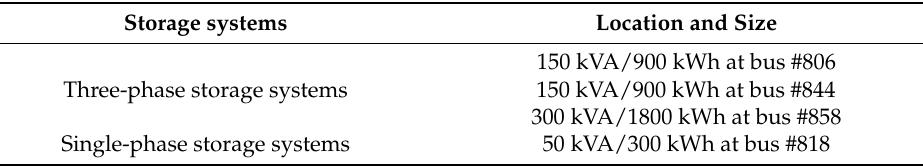
Table 3. Optimal location and size of energy storage systems for Mode 2.